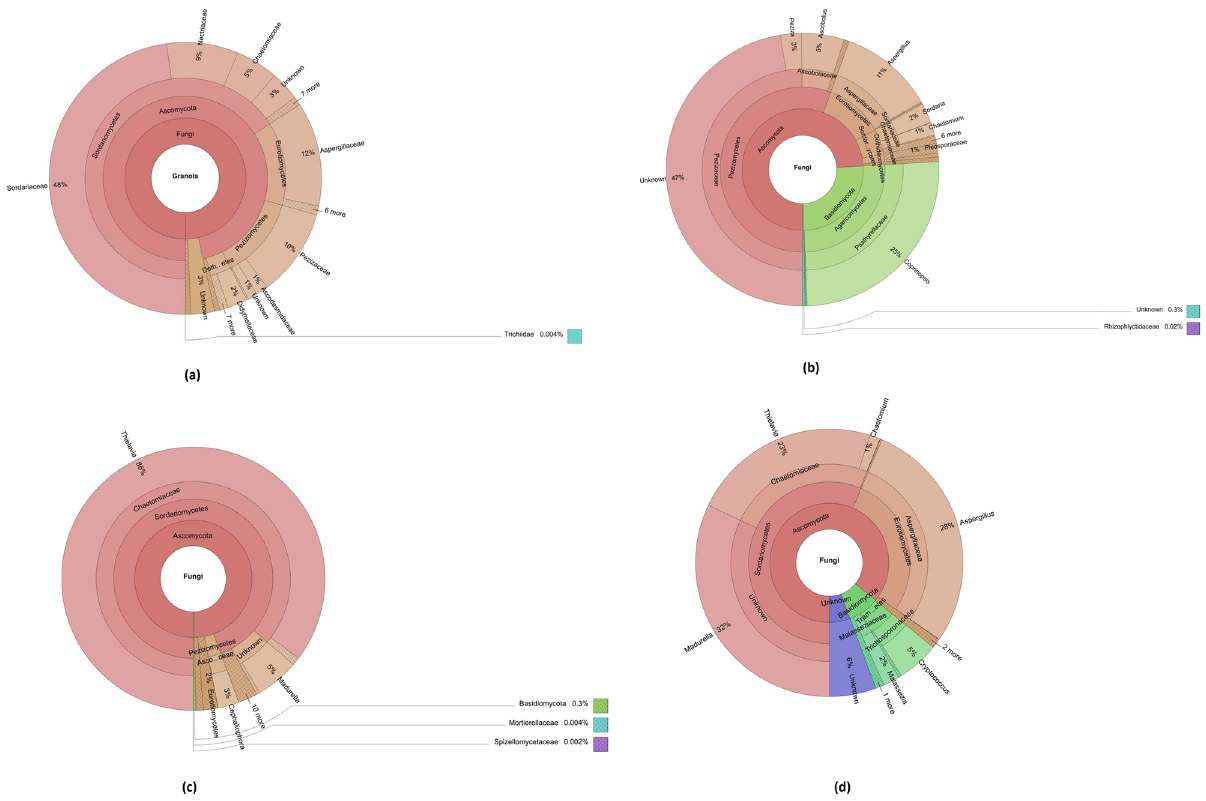
Fig 1. Taxonomic composition of soil samples in the four sites: Khulais (a), Meccaold road (b), Thuwal (c) and Asfan road